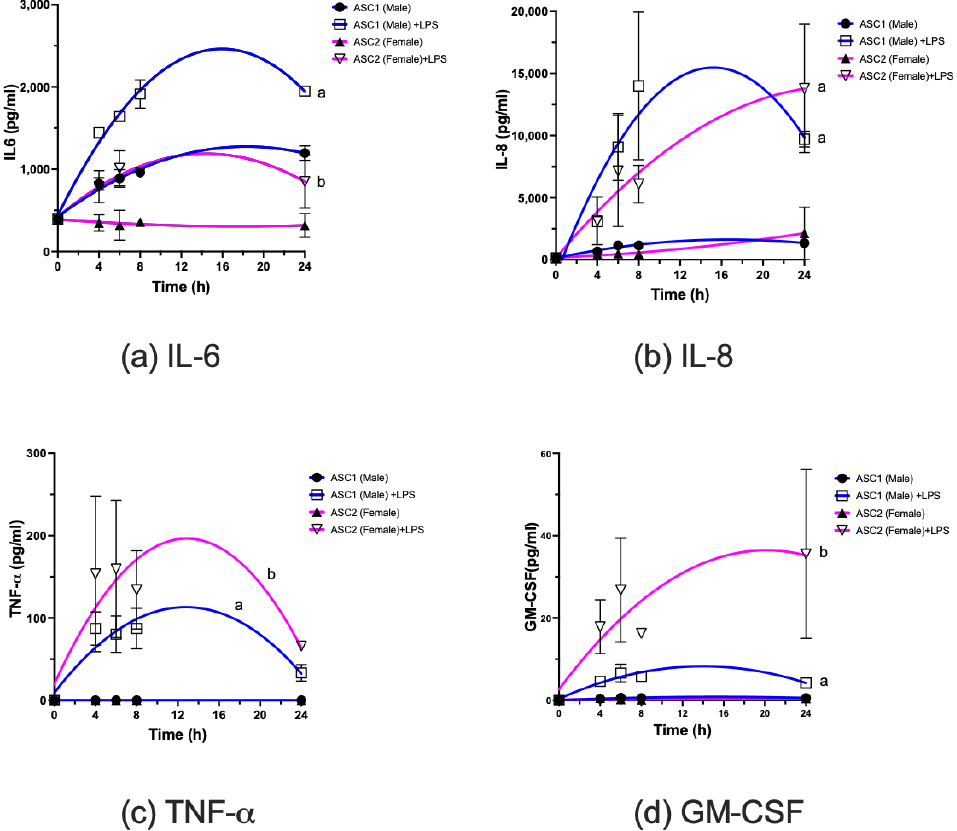
Figure 4. Individual adipose stem cells (ASCs) differentially secrete selected cytokines in response to inflammatory stimuli. ASCs were cultured and treated with or without LPS (10 ng/mL), media were harvested at different time points and selected cytokines protein levels determined as described in Materials and Methods. Results expressed as pg/mL (mean +/ − SD, n = 4). Curves with different letter indicate significantly different at p < 0.05 or less.